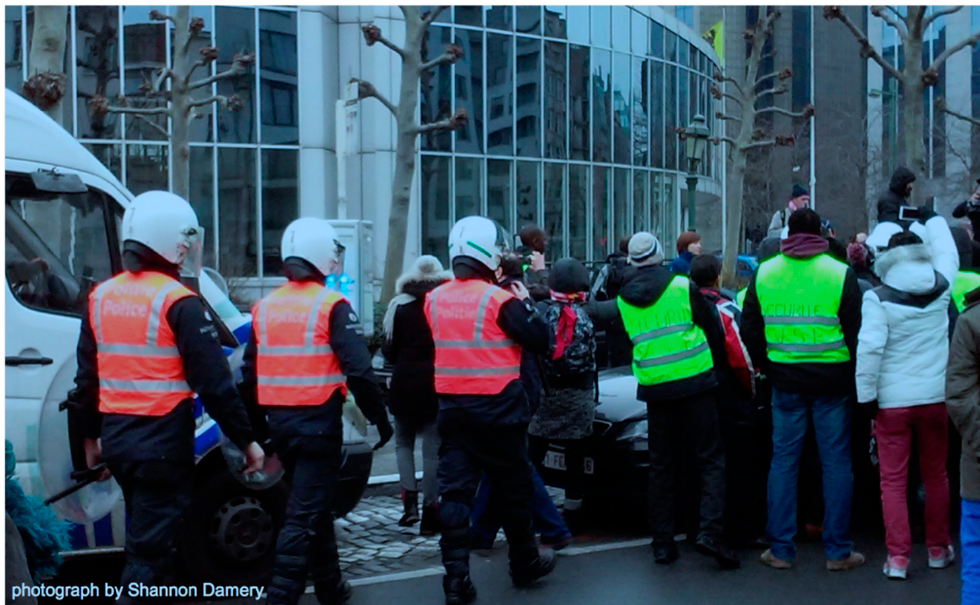
Figure 5. Police and ‘sans papiers security’ at a manifestation in Brussels. 4 March 2015 © Shannon Damery.